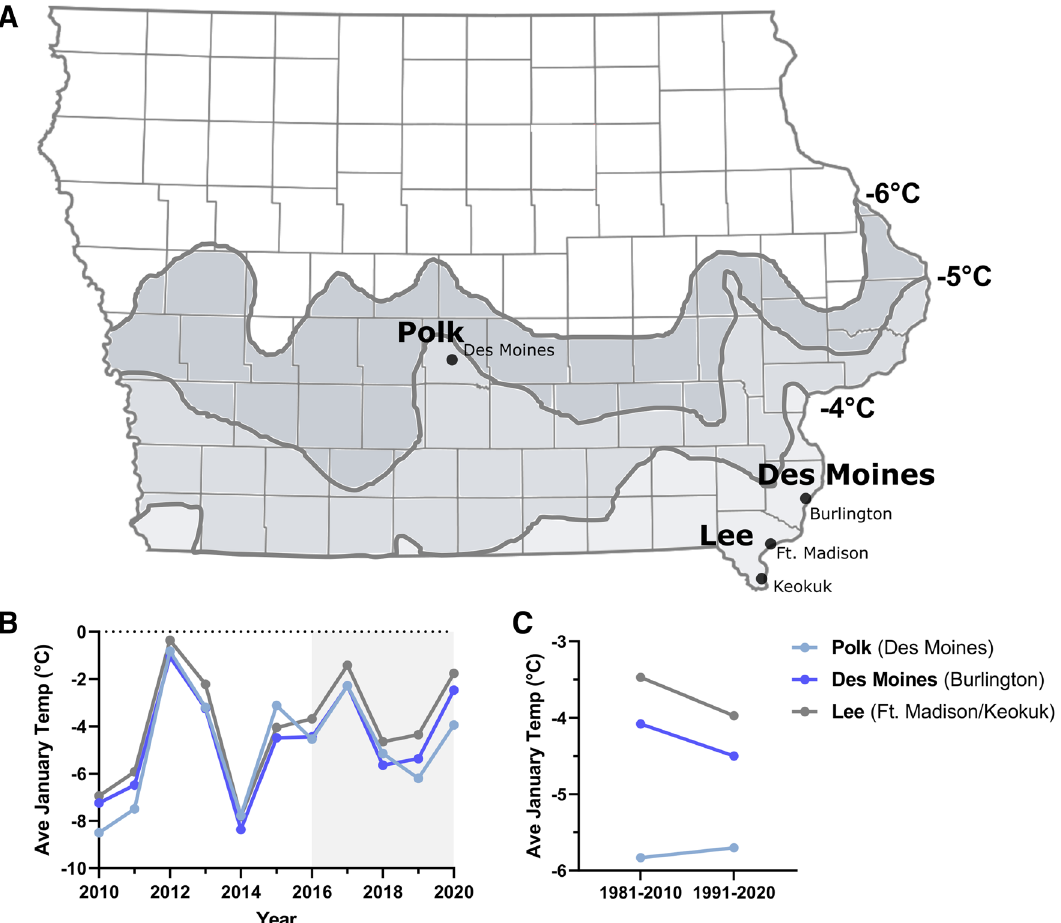
Figure 5. Overwintering temperatures in Iowa. Average winter (December, January, February) temperatures are displayed for Iowa ( A ). Shaded regions represent different temperature isotherms. Cities and counties where stable populations of Ae. albopictus have been detected are shown. Annual January temperatures are displayed from 2010 to 2020 to indicate differences in yearly temperatures for each respective Ae. albopictus -positive county ( B ). The shaded region from 2016 to 2020 represent the study period where targeted trapping efforts have focused on invasive Aedes species. Differences in January temperatures from the 30-year average from 1981–2010 and 1991–2020 examine the potential impacts of climate change on overwintering temperatures ( C